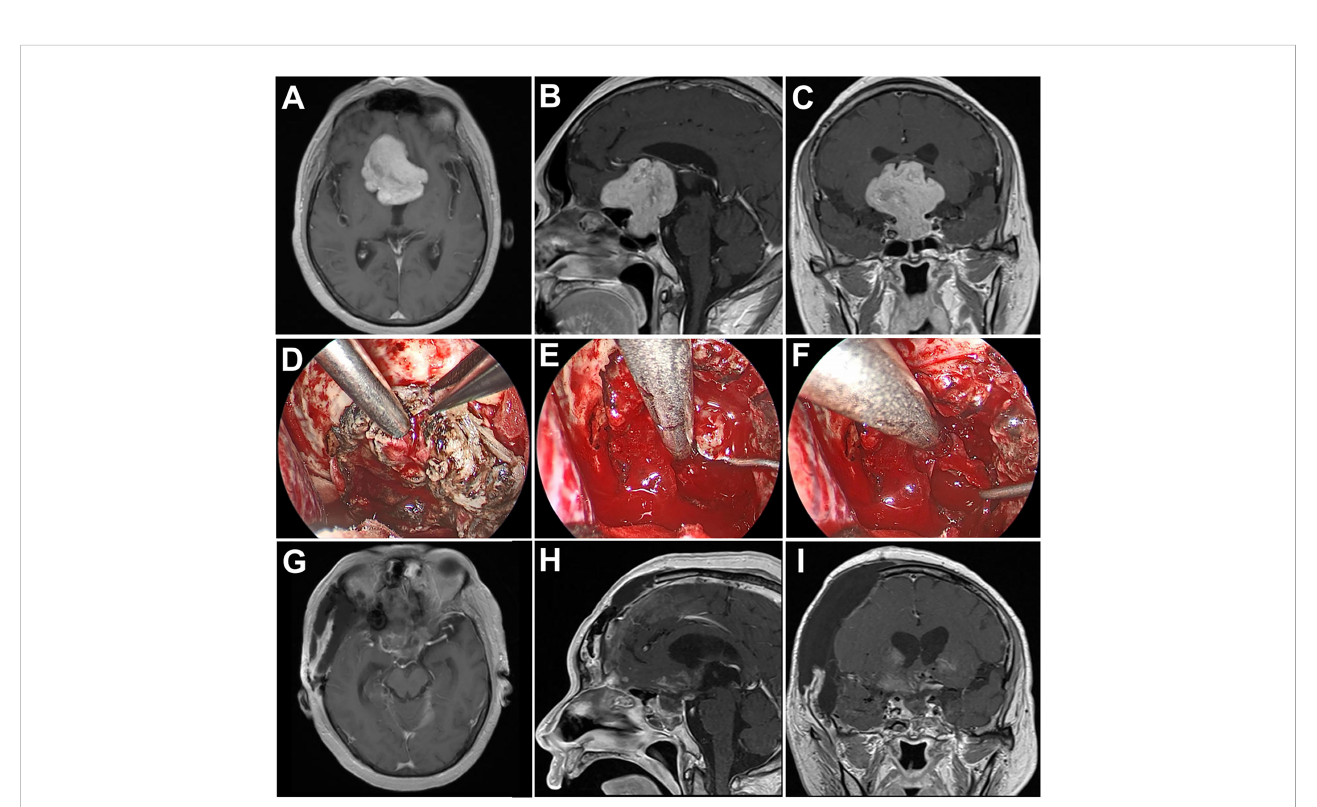
FIGURE 5 Case 4. Pre- and postoperative imaging fi ndings and intraoperative images. (A – C) Preoperative axial (A) , sagittal (B) and coronal (C) gadolinium- enhanced T1-weighted MRI images showing a giant pituitary adenoma with extensive suprasellar extension. (D) Intraoperative photograph showing that the diaphragma sellae is cut with micro-scissors. (E, F) Intraoperative endoscopic photographs showing the fi nal view of the medial walls of both sides of cavernous sinus as well as the anterior wall of sella turcica after removal of the tumor. (G – I) Postoperative axial (G) , sagittal (H) and coronal (I) gadolinium-enhanced T1-weighted MRI images showing gross total resection of the pituitary